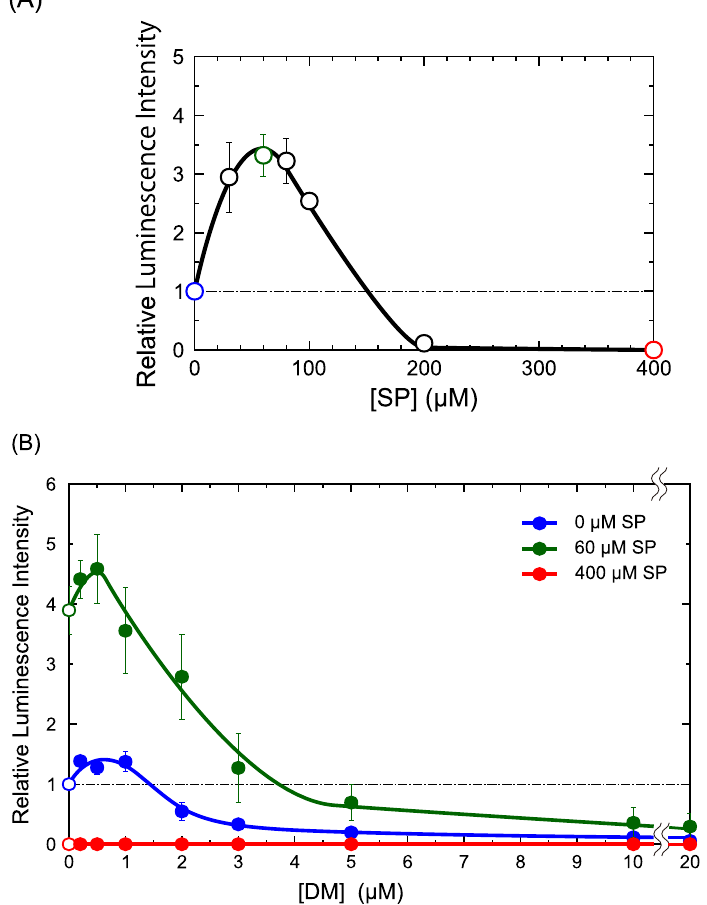
Figure 1. Cell-free gene expression relative to luminescence intensity. Efficiency of gene expression was measured for various concentrations of ( A ) spermine (SP) and ( B ) daunomycin (DM) at different SP concentrations. The intensity was normalized to the control (=1), where SP and DM were absent. The DNA concentration was fixed at 0.6 µM in the nucleotide unit. The error bars show the standard deviation.